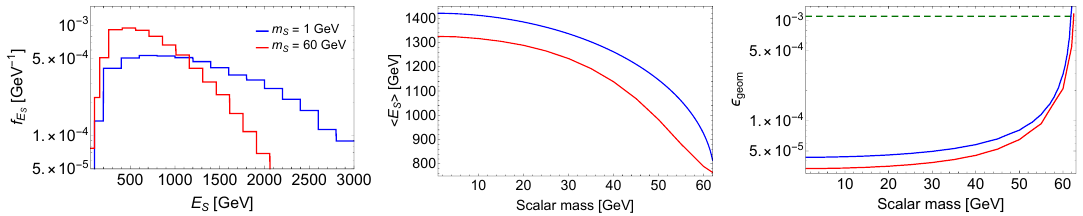
Figure 6 . The analytic estimate (2.15) for the maximal number of scalar decays in FASER2 decay volume versus the scalar mass. See text for details.